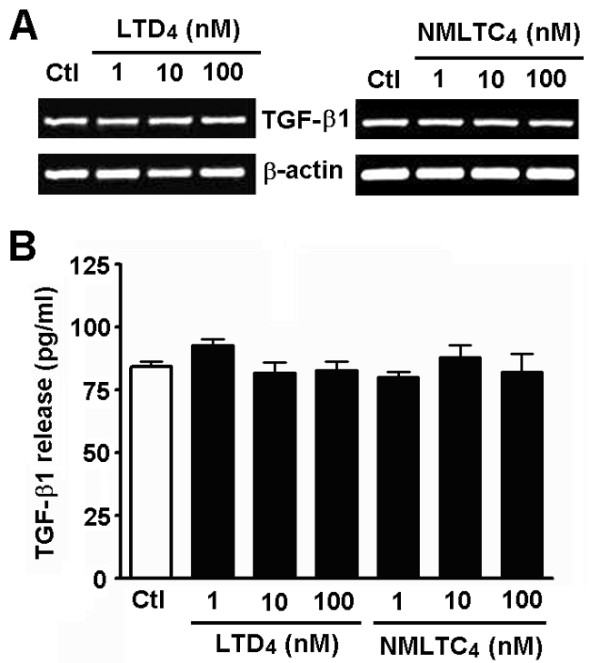
Effects of LTD4and NMLTC4on TGF-β1 mRNA expression and TGF-β1 release in astrocytes. (A), RT-PCR analysis showing mRNA expression of TGF-β1 after treatment with 1, 10 and 100 nM LTD4 or NMLTC4 for 24 h. There was no significant difference in TGF-β1 expression after treatment with LTD4 and NMLTC4 (n = 4 for each group, P >0.05). (B) TGF-β1 release in the culture supernatants after exposure to LTD4 and NMLTC4 measured by ELISA. Neither LTD4 nor NMLTC4 affected TGF-β1 expression and release. Data are reported as mean ± S.E.M.; n = 6.